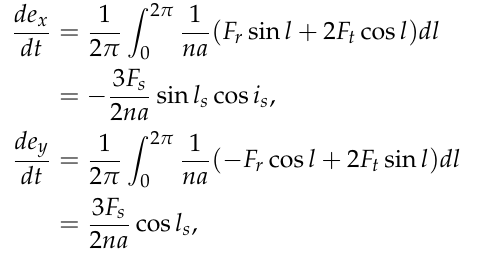
Figure 11. ∆ i for control period ∆ T C = 100 Earth days with initial inclination vector point ( i x the inclination limited circle whose radius r = 4.58 × 10 − 5 deg perturbed by solar